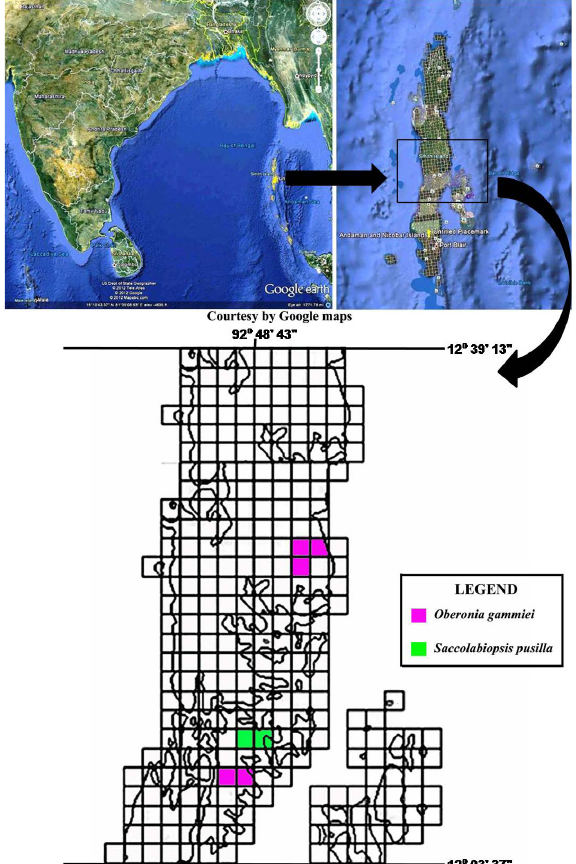
Image 3. Distribution map of Saccolabiopsis pusilla and Oberonia